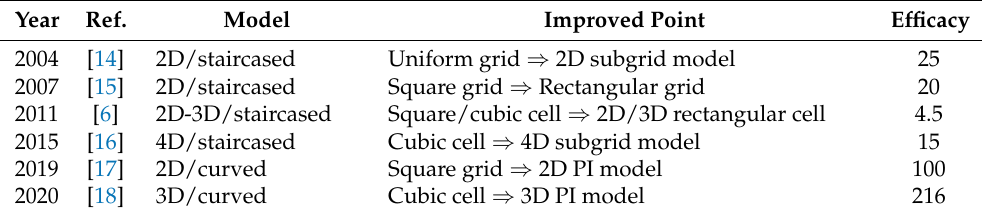
Table 1. Strategy status of the curved surface analysis in the NS-FDTD method (Efficacy: Decreasing rate of the calculation cell number used for the verification of the model in the paper or